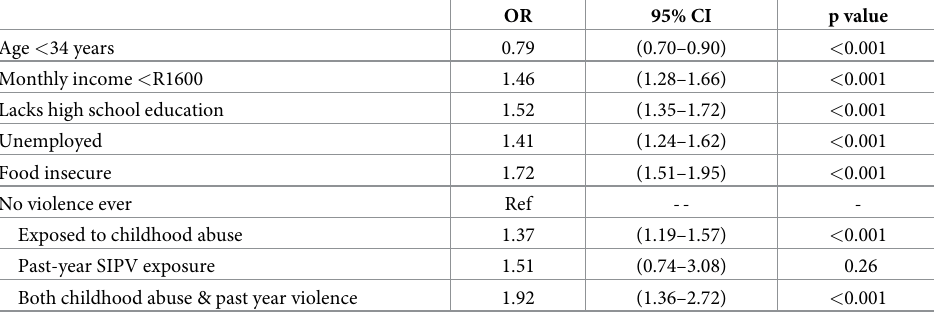
Table 2. Associations of key covariates and elevated depressive symptoms.